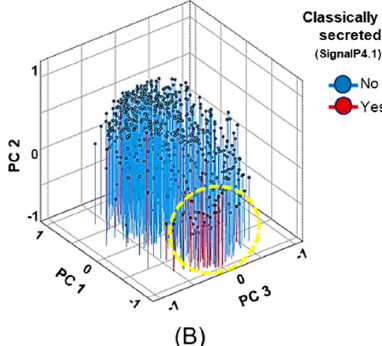
Figure 3. ( A ) Heatmap of row-wise standardized protein abundances (complete linkage, Lp norm; p = 1.5) with eleven clusters (distance threshold set at 50). Protein clusters with similar trends in specificity are circled. ( B ) 3D-PCA comparing protein abundance patterns with respect to their predicted secretion modes (predicted moonlighters are